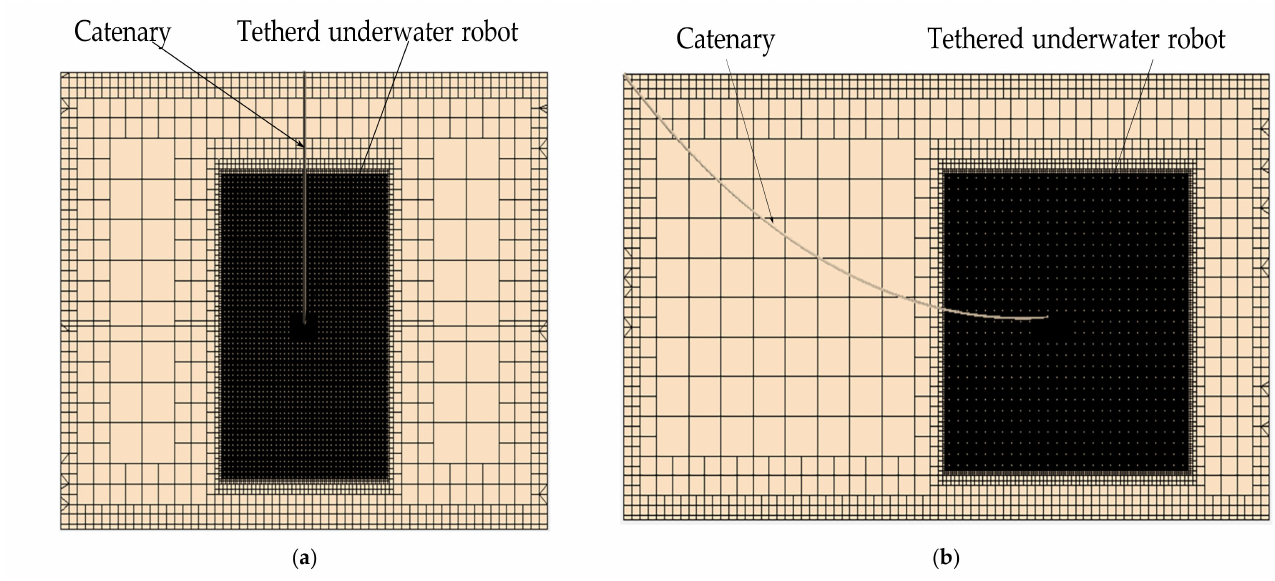
Figure 5. The cutaway view of computational domain mesh: ( a ) the left view of the computational domain; ( b ) the front view of the computational